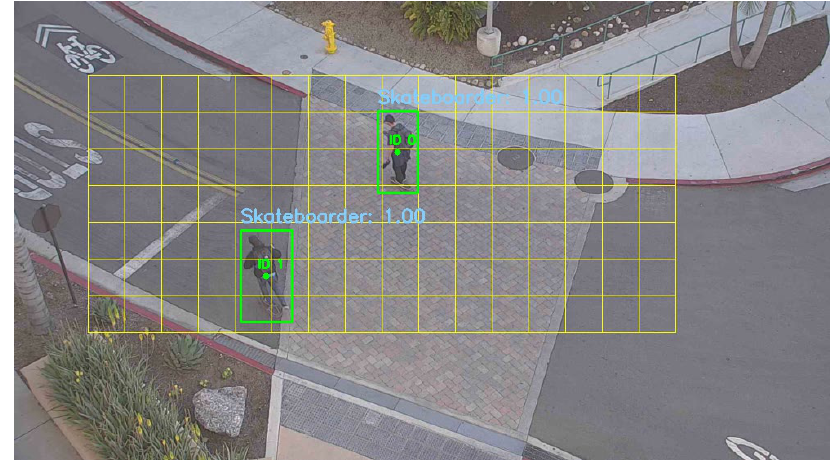
Figure 24. Both skateboarders are correctly detected and registered inside the grid area with unique IDs.